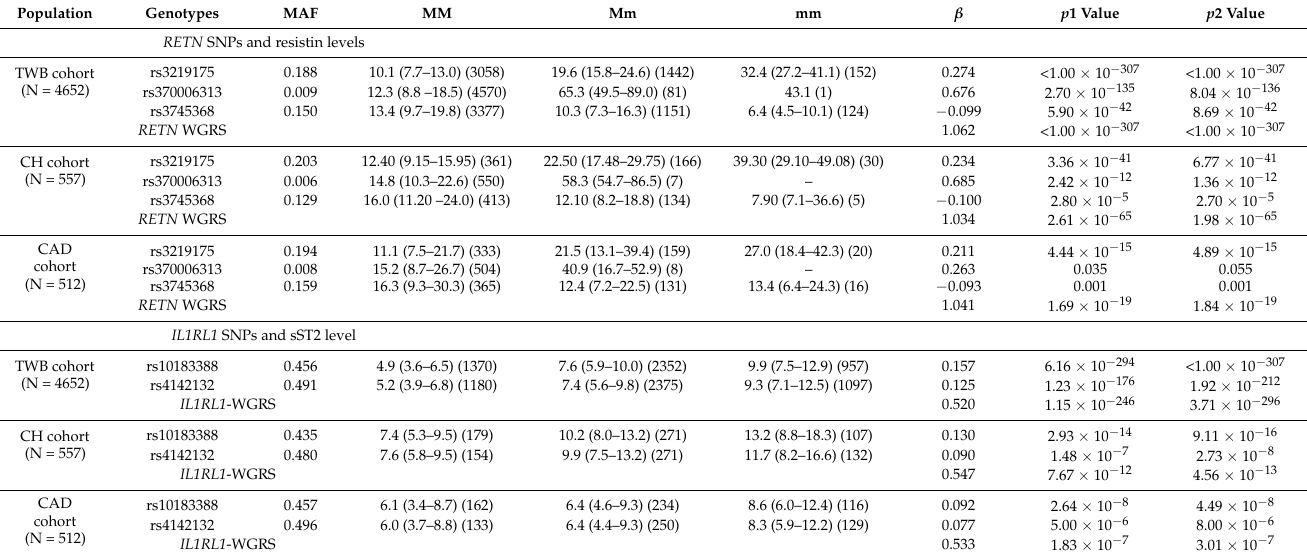
Table 1. Associations of RETN SNPs with resistin levels and IL1RL1 SNPs with sST2 levels in the study populations.